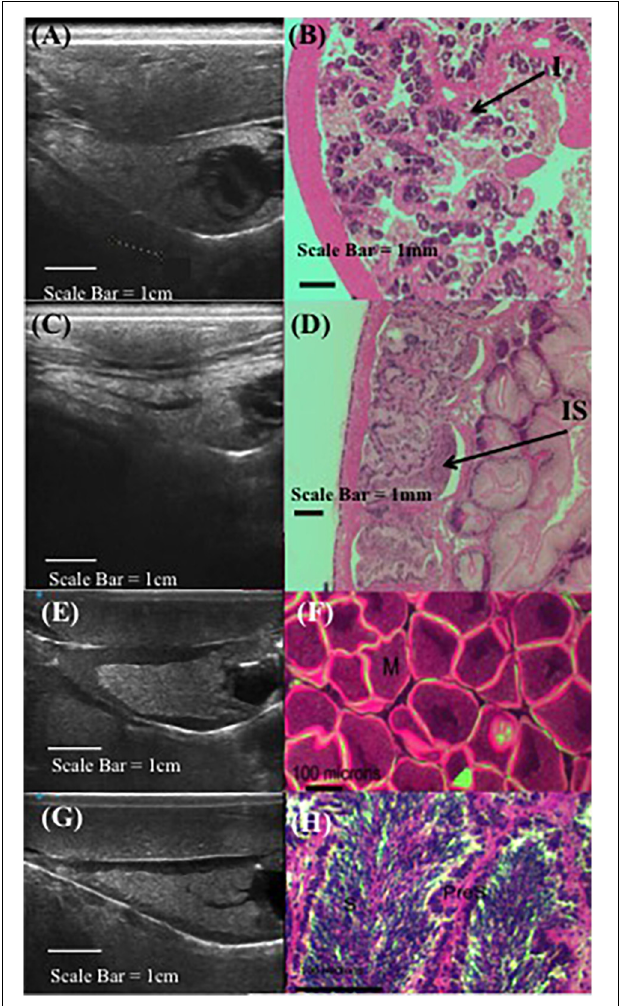
FIGURE 2 | Comparative red abalone ( Haliotis rufescens ) histology and ultrasonography. Paired ultrasound (A) and histology (B) images from a non-reproductive female, where (I) indicates immature oocytes. Paired ultrasound (C) and histology (D) images from a non-reproductive male, where (IS) indicates immature spermatocytes. Unpaired ultrasound (E) and histology in gravid female (F) , where (M) indicates mature eggs. Unpaired ultrasound (G) and histology (H) in male abalone, where (S) indicates sperm and (PreS) indicates pre-sperm. Note, (F) and (H) from Rogers-Bennett et al.